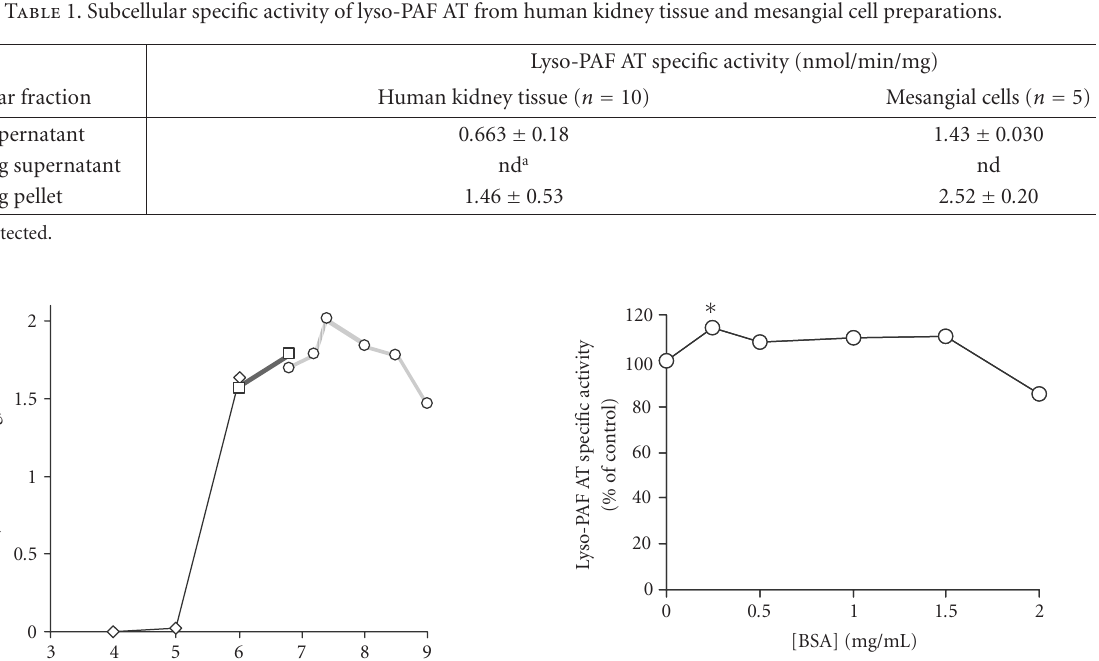
Figure 2. E ff ect of BSA concentration on lyso-PAF AT specific activity of mesangial cells: TM fractions of HMC 0 . 23 mg/mL were incubated in the presence of di ff erent concentrations of BSA. Results are expressed as percent related to non-added con- trol (100%). Results are the average of two independent deter- minations using di ff erent enzyme preparations performing du- plicate samples. ∗ P < . 05 versus